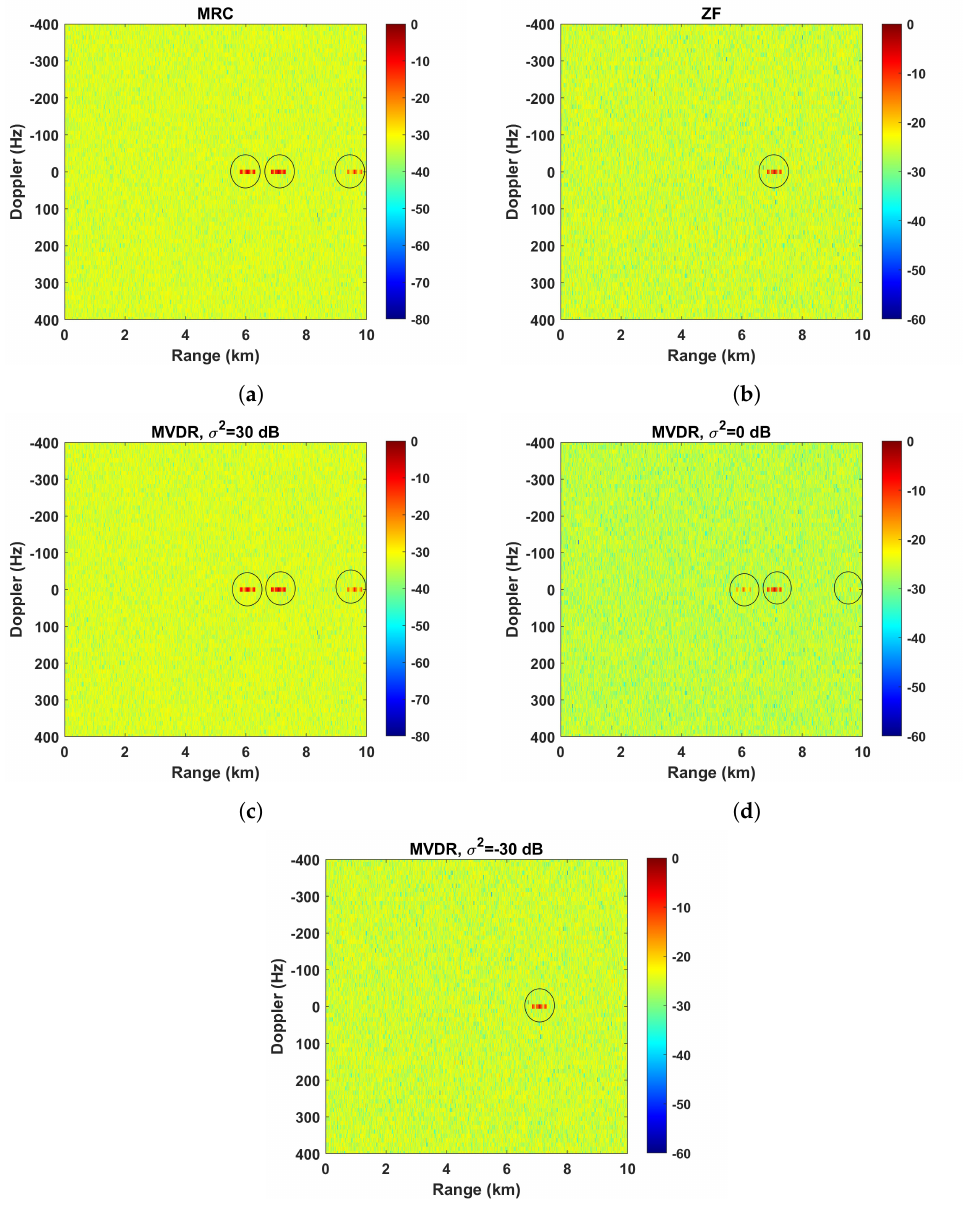
Figure 7. Range–Doppler map applying different beamforming techniques before the CAF: ( a ) MRC; ( b ) ZF; ( c ) MVDR ( σ 2 = 30 dB); ( d ) MVDR ( σ 2 = 0 dB); ( e ) MVDR ( σ 2 = − 30